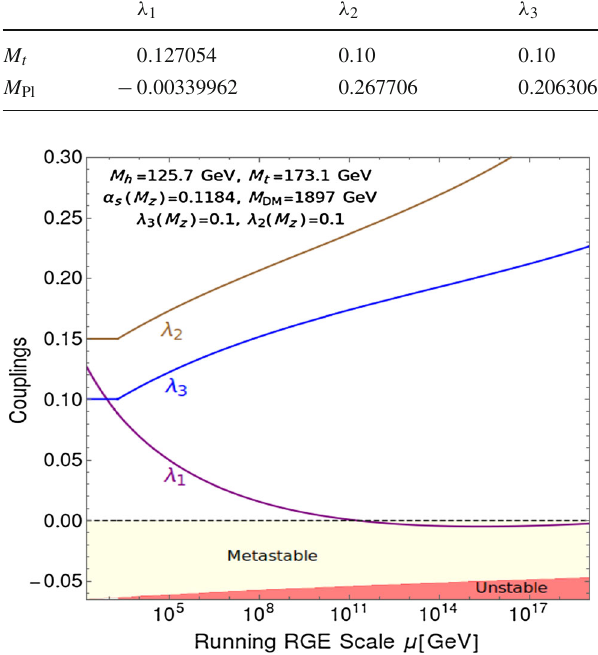
Fig. 3 RG evolution of the couplings λ 1 , 2 , 3 for the set of parameters in Table 1 with DM mass M DM = 1897